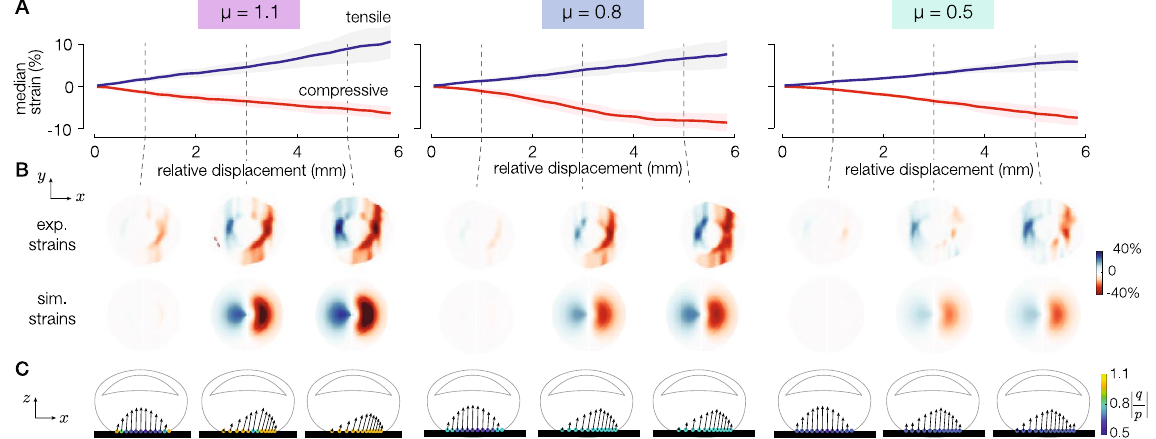
Figure 3. Typical trial. ( A ) Compressive and tensile strain fields for 3 different friction conditions as a function of the relative lateral displacement. The solid lines and the shaded areas represent the mean ± std. ( B ) Experimental and simulated strain profiles for the 3 different friction conditions at three positions on the plate from 1 to 5 mm. ( C ) The corresponding simulated surface finger profile. The blue arrows represent the pressure p and traction q acting on each element, and the color of the dots represents the local pressure ratio | q / p